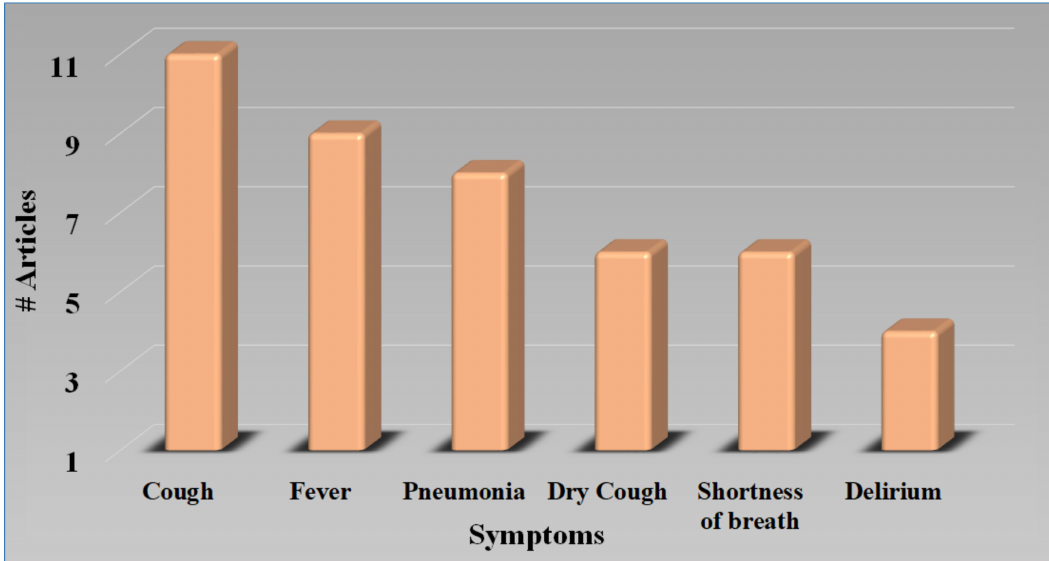
Figure 8. The symptoms of COVID-19 in PD